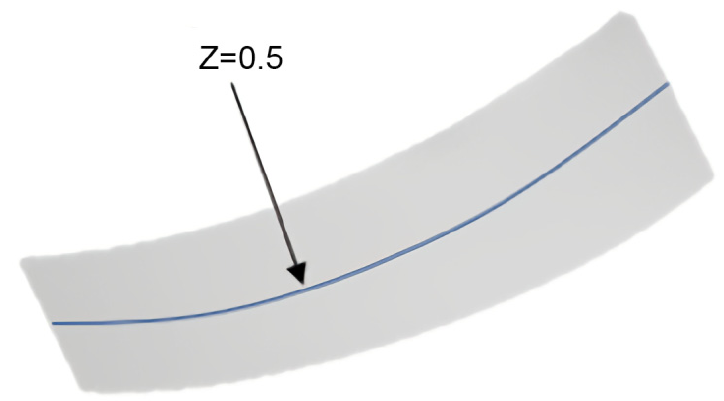
Figure 10. Blade’s surface-pressure sampling curve.